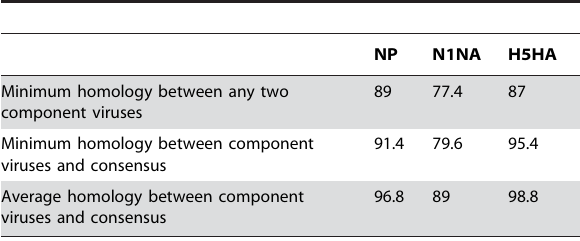
Table 2. Quantitative Comparison of Homologies Between Component and Consensus